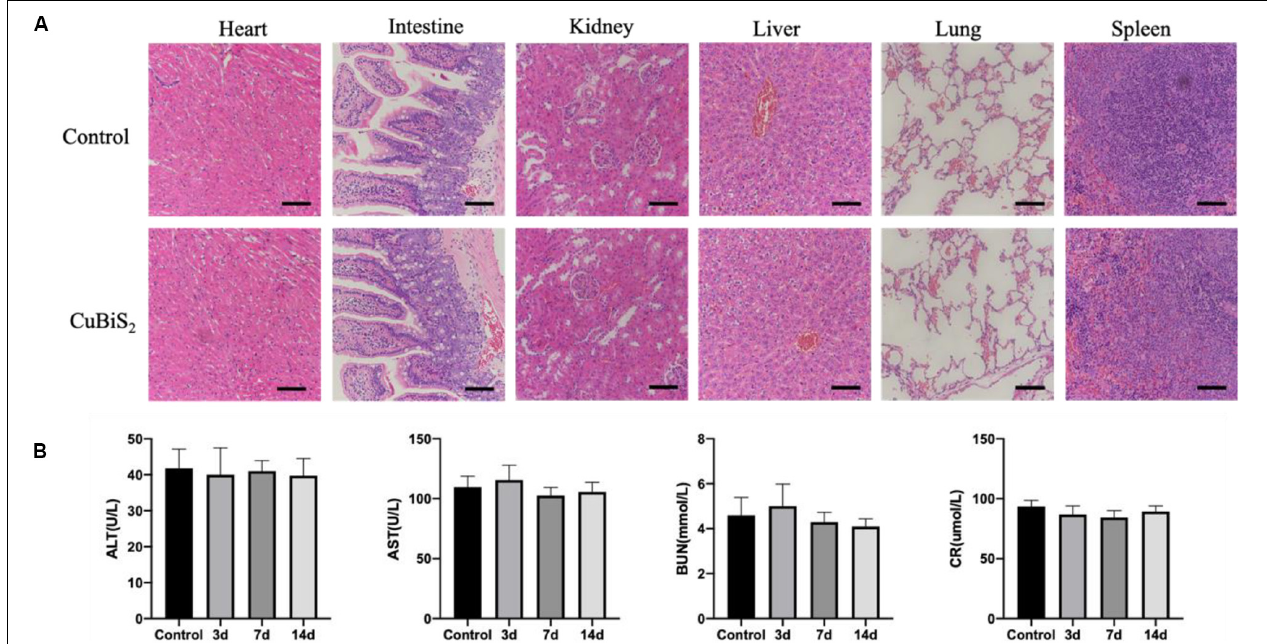
FIGURE 9 | In vivo biocompatibility test of CuBiS 2 NPs. (A) HE staining of major viscera showed no obvious histopathological changes in heart, intestine, kidney, liver, lung, or spleen between the control group and the CuBiS 2 group. Scale bar: 50 µ m. (B) Laboratory blood test of control group and CuBiS 2 group at different time points (3, 7, 14 days) after CuBiS 2 NPs injection, including alanine aminotransferase (ALT), aspartate aminotransferase (AST), blood urea nitrogen (BUN), and creatinine